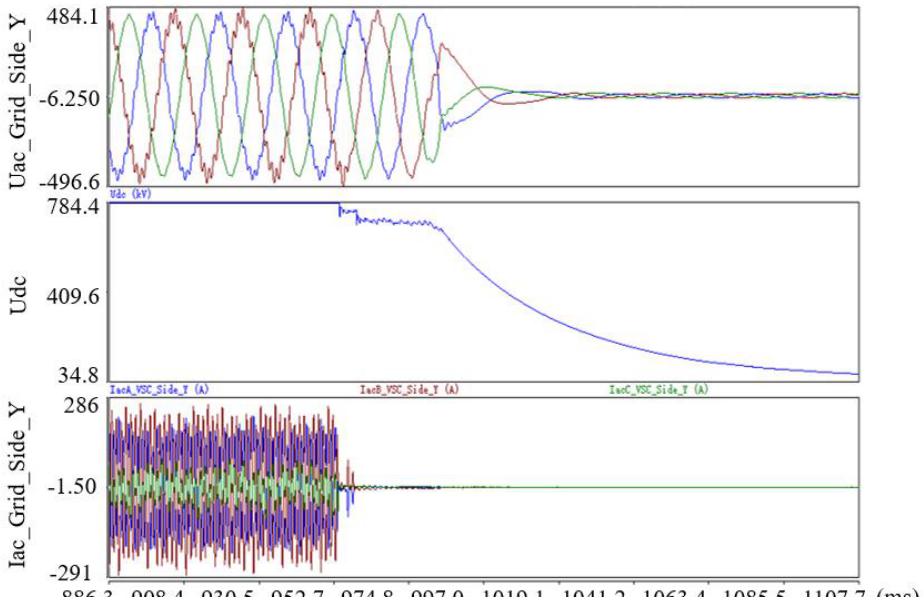
Figure 4. Waveform of second high-frequency oscillation.